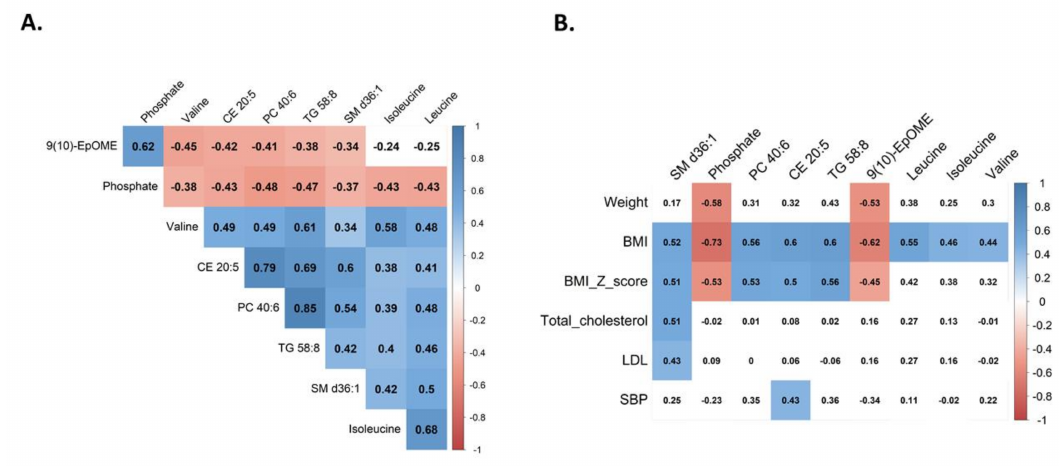
Figure 10. Heatmap of the Pearson correlation coefficient matrix: ( A ) Correlations between selected metabolites and ( B ) between selected metabolites and clinical variables. Red and blue indicate nega- tive and positive correlations, respectively. Color intensity indicates the absolute correlation value. Empty cells indicate non-significant correlations (adjusted p -values > 0.05). SM, sphingomyelin; PC, phosphatidylcholine; CE, cholesteryl ester; TG, triacylglycerol; 9,10-EpOME, 9,10-epoxyoctadecenoic acid; BMI, body mass index; LDL, low-density lipoprotein cholesterol; SBP, systolic blood